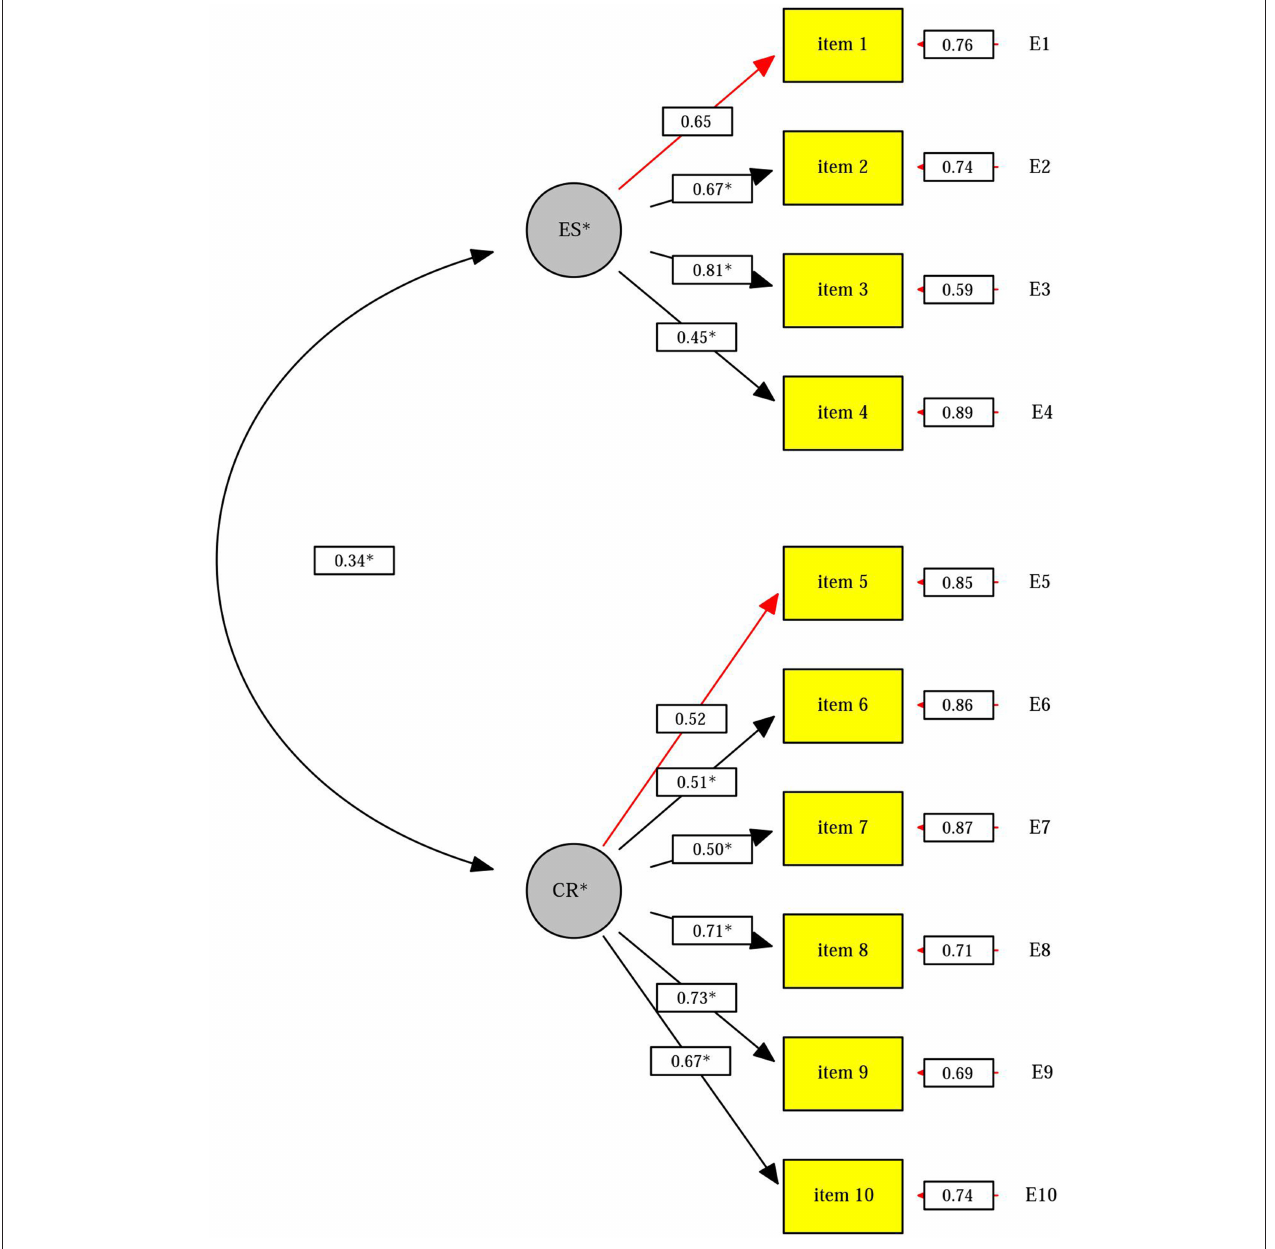
FIGURE 1 | Normalized CFA coefficients in the ERQ items. Note: CR, cognitive reappraisal; ES, expressive suppression. * p < 0.05